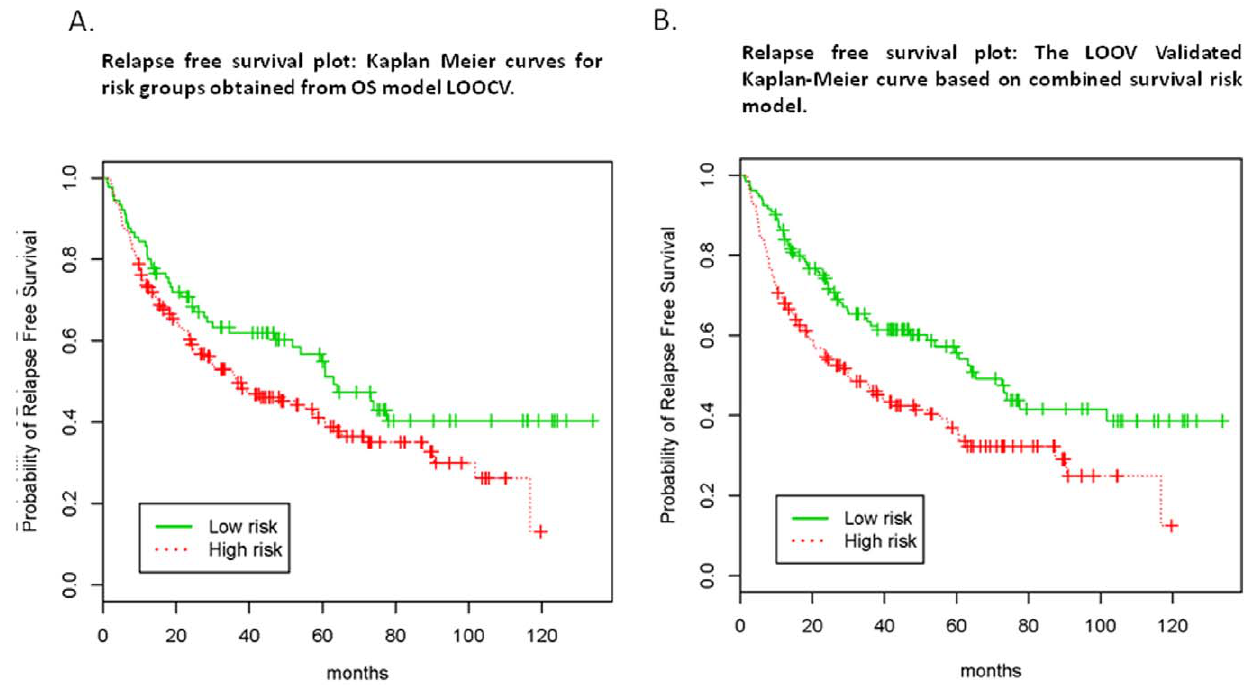
Figure 4. The LOOV Validated Kaplan-Meier curve based on combined survival risk model. The LOOCV Kaplan-Meier curves showed that the five-marker OS model (Figure 4A) and the combined model (five-marker + stage model) (Figure 4B) may be used to predict RFS survival data. In each round of LOOCV, the model was built in the training set using the OS information and tested on the left out sample using the RFS information.